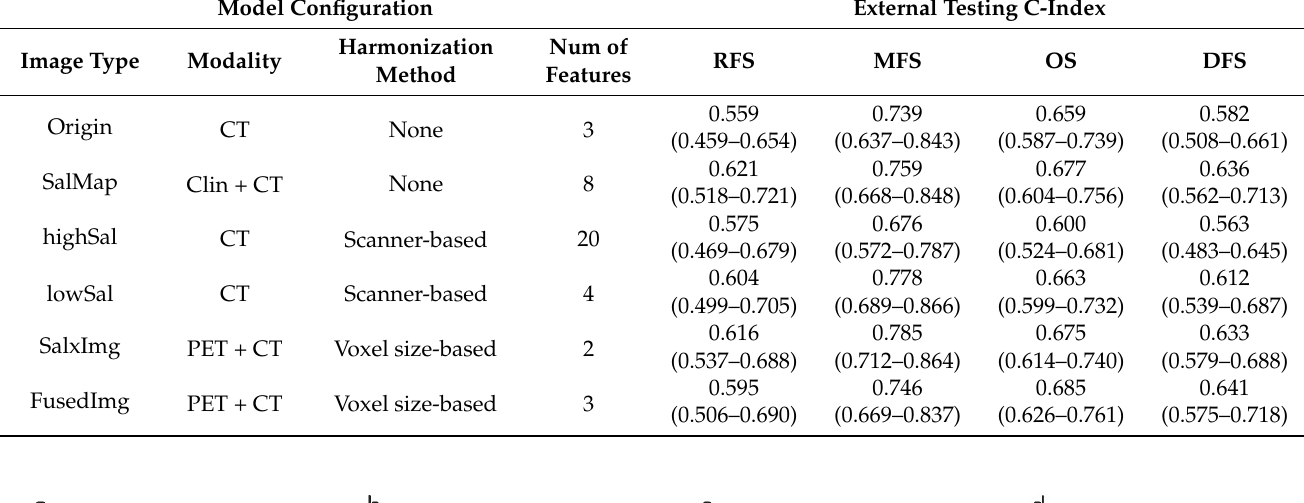
Table 2. C-index (95% confidence interval), model configuration (including image type, modality, and harmonization method), and number of features for each model in the external testing cohorts. Best performances are also highlighted.